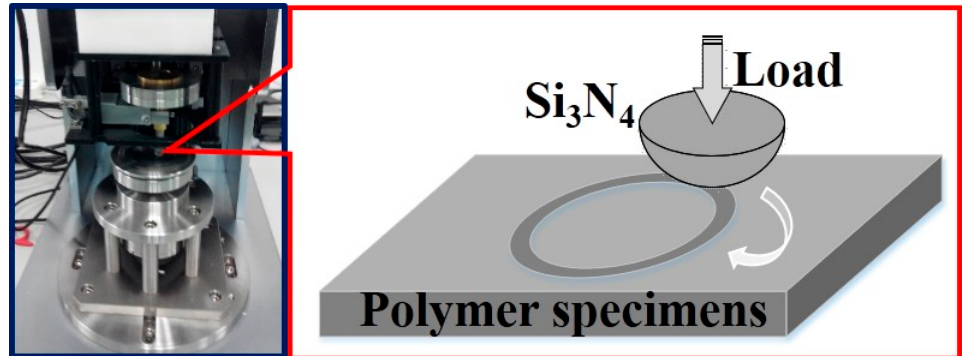
Figure 6. Equipment picture and contact schematic diagram for measuring friction.